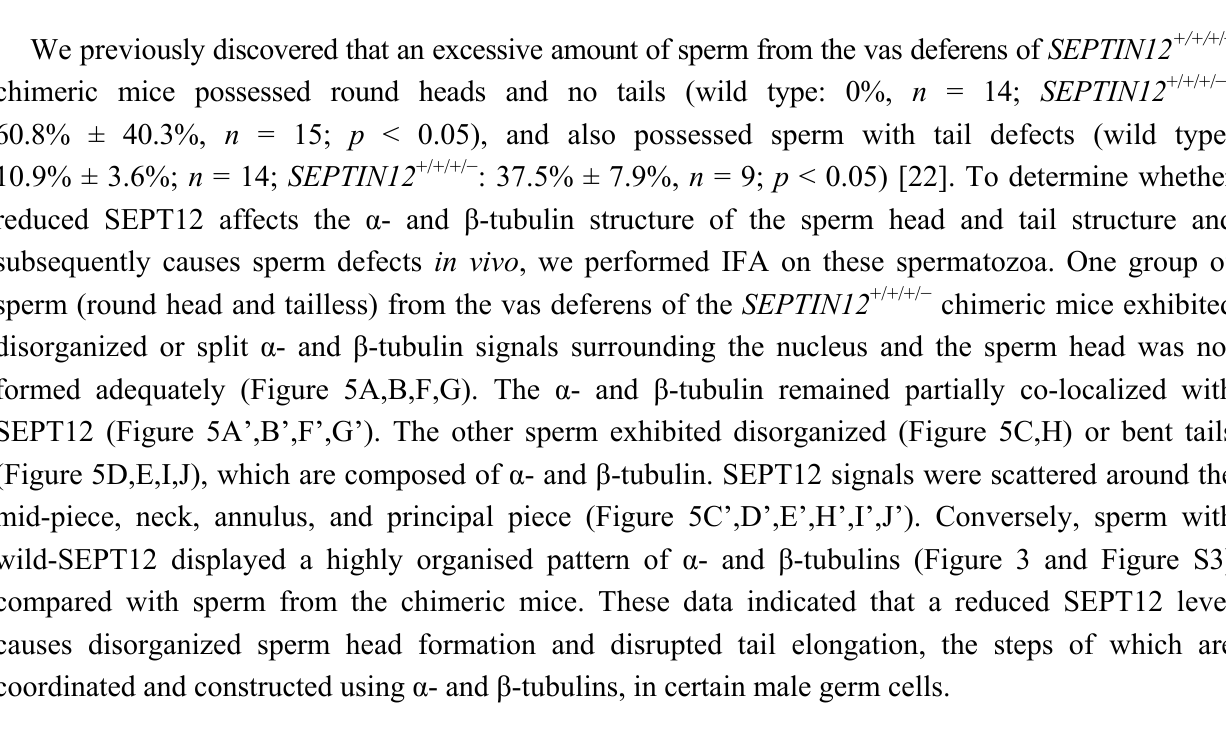
Figure 5. Reduced SEPT12 expression influences the α - and β -tubulins structure of head and tail in spermatozoa isolated from the Septin12 +/+/+/ − chimeras. Analysis of spermatozoa from Septin12 +/+/+/ − chimeras mice ( A – J’ ). Spermatozoa were stained with anti- α